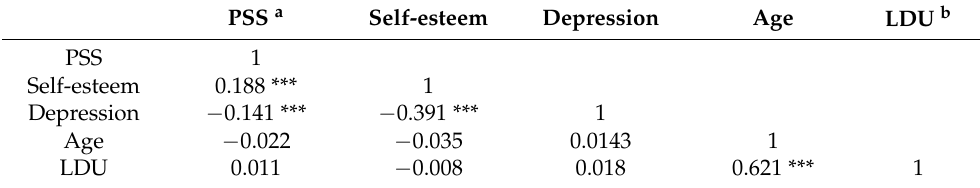
Table 2. Correlation between continuous